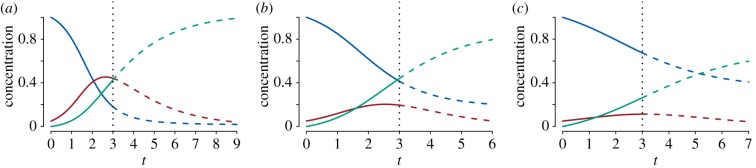
The SIR curves for the three different parameter values considered in §3.4. The initial values are S0 = 1, R0 = ρ and R0 = 0. The vertical dotted lines represent the cut-off times. (a) β = 2, γ = 0.5, ρ = 0.05, (b) β = 2, γ = 1.0, ρ = 0.05, (c) β = 1.5, γ = 1.0, ρ = 0.05. (Online version in colour.)